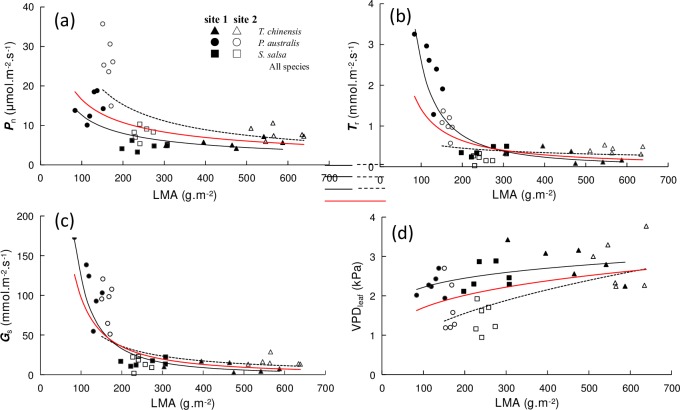
Relationships between LMA and gas exchange characteristics of halophytic plant communities.(a) LMA and Pn (equation for site 1: y = 255.59x−0.654, R2 = 0.489, P = 0.001; equation for site 2: y = 935.77x−0.777, R2 = 0.481, P = 0.001; equation for all species: y = 295.94x−0.626, R2 = 0.321, P < 0.001); (b) LMA and Tr (equation for site 1: y = 7037x−1.721, R2 = 0.792, P < 0.001; equation for site 2: y = 3.8727x−0.403, R2 = 0.053, P = 0.358; equation for all species: y = 268.35x−1.139, R2 = 0.375, P < 0.001); (c) LMA and Gs (equation for site 1: y = 729930x−1.89, R2 = 0.804, P < 0.001; equation for site 2: y = 9216.9x−1.048, R2 = 0.270, P = 0.027; equation for all species: y = 80893x−1.46, R2 = 0.511, P < 0.001); (d) LMA and VPDleaf (equation for site 1: y = 1.1491x0.1426, R2 = 0.272, P = 0.026; equation for site 2: y = 0.1273x0.4721, R2 = 0.397, P = 0.005; equation for all species: y = 0.5527x0.2437, R2 = 0.160, P = 0.015).